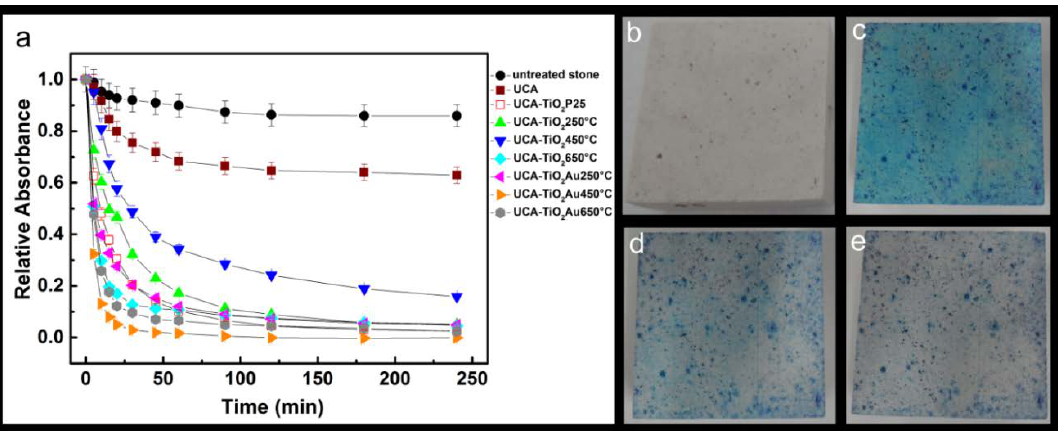
Figure 6. ( a ) Evolution of photocatalytic degradation of Methylene blue (MB) on stone specimens treated with UCA–TiO 2 and UCA–TiO 2 Au series, UCA–TiO 2 P25 as reference material, as well as the untreated specimen. Each data point is the mean of three replicates. MB degradation on the stone treated with UCA–TiO 2 Au 450 °C obtained at different irradiation times: untreated stone ( b ), 0 min ( c ), 30 min ( d ) and 60 min ( e ).